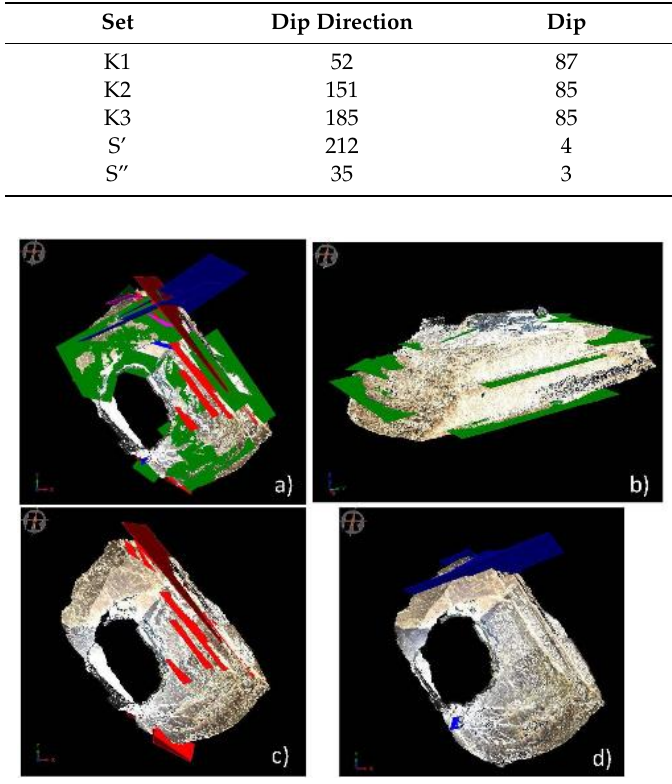
Table 3. Average attitude of the discontinuity sets at Castellana Caves, identified through geo-structural analysis on point cloud.